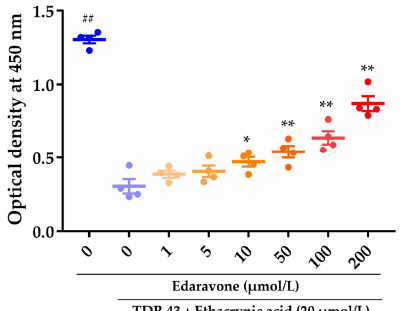
Figure 1. Effects of edaravone against neurotoxicity in rat neural stem cell-derived neurons trans- duced with adenoviruses expressing wild-type and C-terminal fragment TDP-43 and treated with ethacrynic acid. Neurotoxicity was analyzed as a decrease in cell viability using the CCK-8 assay. Data are expressed as mean ± standard error of the mean (n = 4 wells in 1 experiment). ## p < 0.01 compared to the group of TDP-43 plus ethacrynic acid (Student’s t-test). * p < 0.05, ** p < 0.01 com- pared to the group of TDP-43 plus ethacrynic acid (Williams’ multiple comparison test).